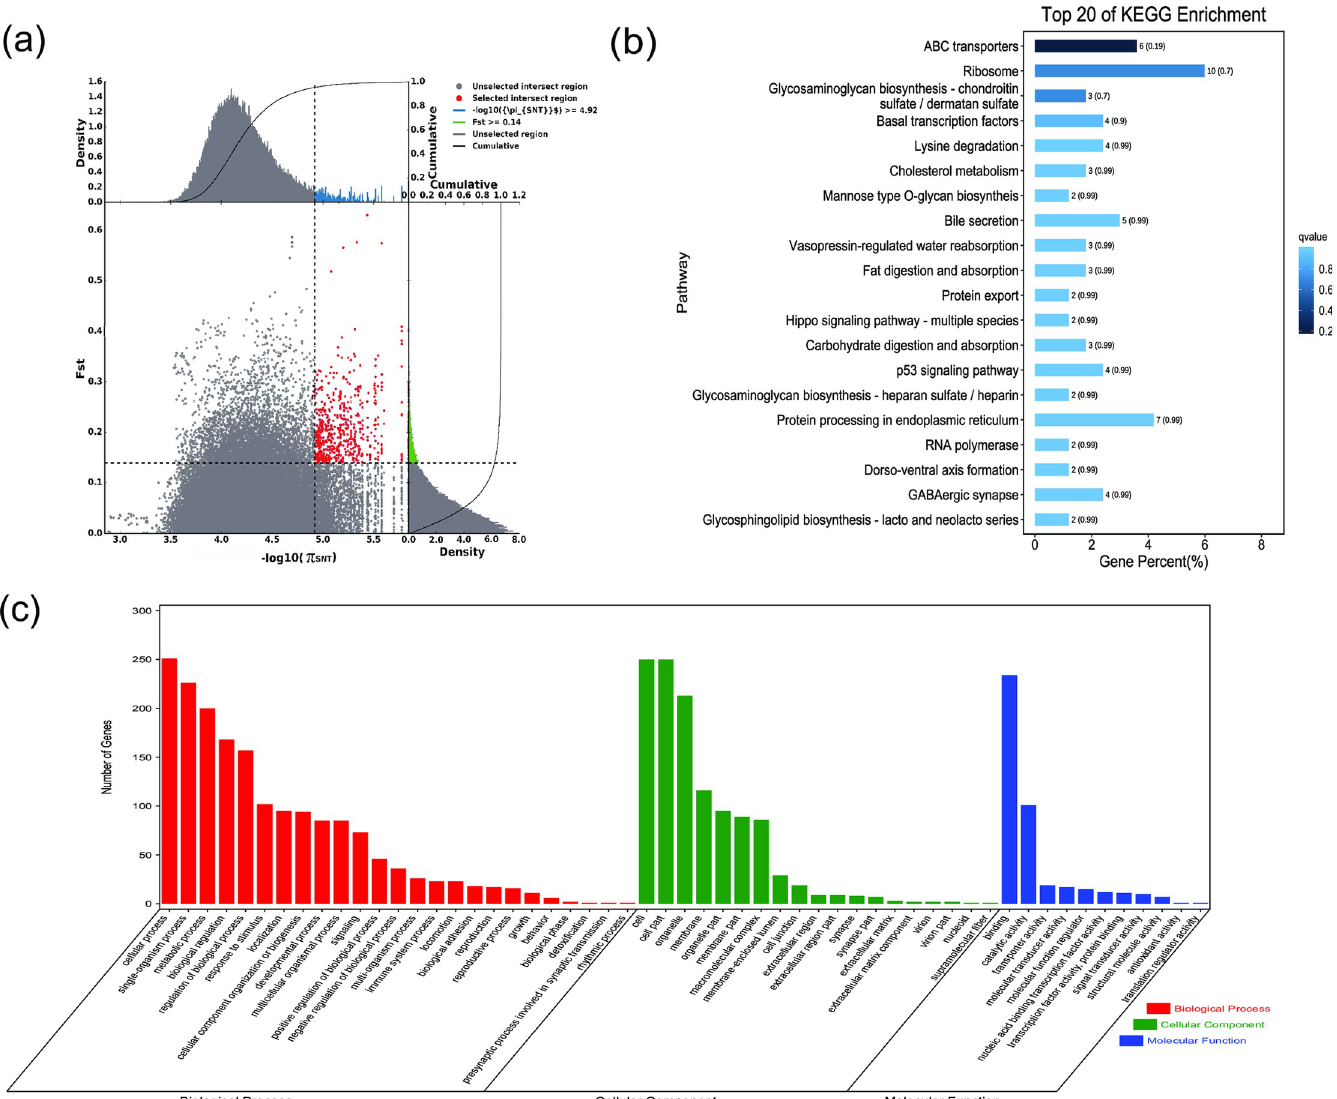
Fig 3. GO classification and KEGG enrichment of the selected genes of Sunite camels. (a) With the pool of all remaining others as the reference population and Sunite camels as the target population, 494 selected genes were obtained. (b) KEGG enrichment of 494 selected genes of Sunite camels. (c) GO classification of 494 selected genes of Sunite